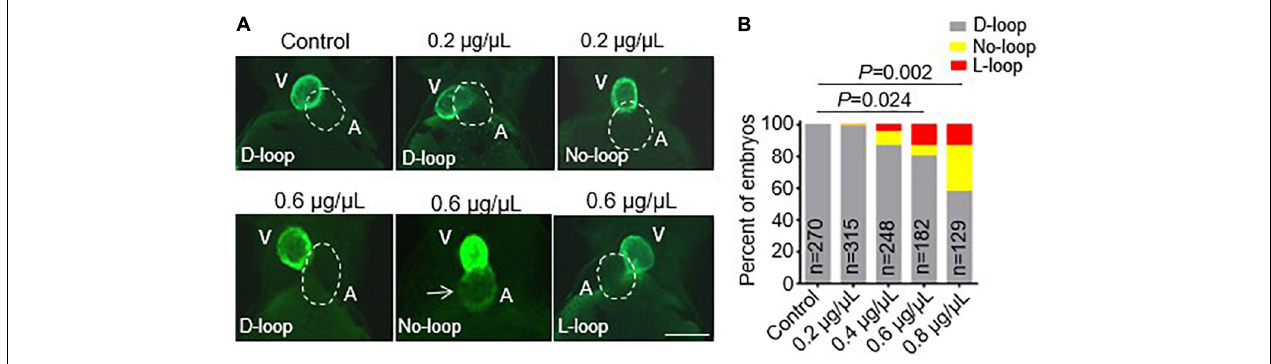
FIGURE 3 | CPAAHTs exposure induced ectopic expression of vmhc gene in the atrium and caused cardiac-looping defects to dose-dependently. (A,B) Representative images of heart-looping morphology (A) and quantification analysis (B) of the percentage of the vmhc KI − EGFP KI embryos with corresponding cardiac-looping structure after exposure to different concentrations of CPAAHTs compared to untreated control at 48 hpf. The arrow points to the ectopic expression of the EGFP signal in the atrium. The dotted line outlines the shape of the atrium. V, ventricle. A, atrium. N = 129–315, chi-squared